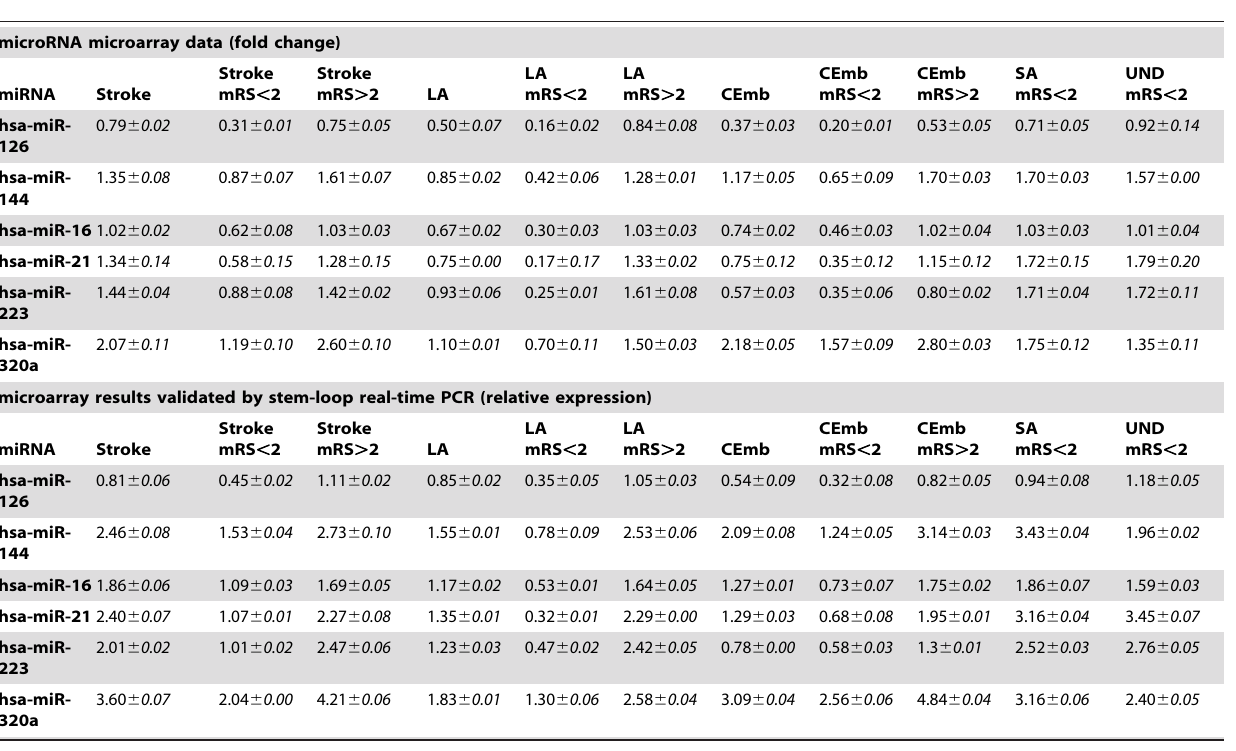
Table 1. Validation of microarray